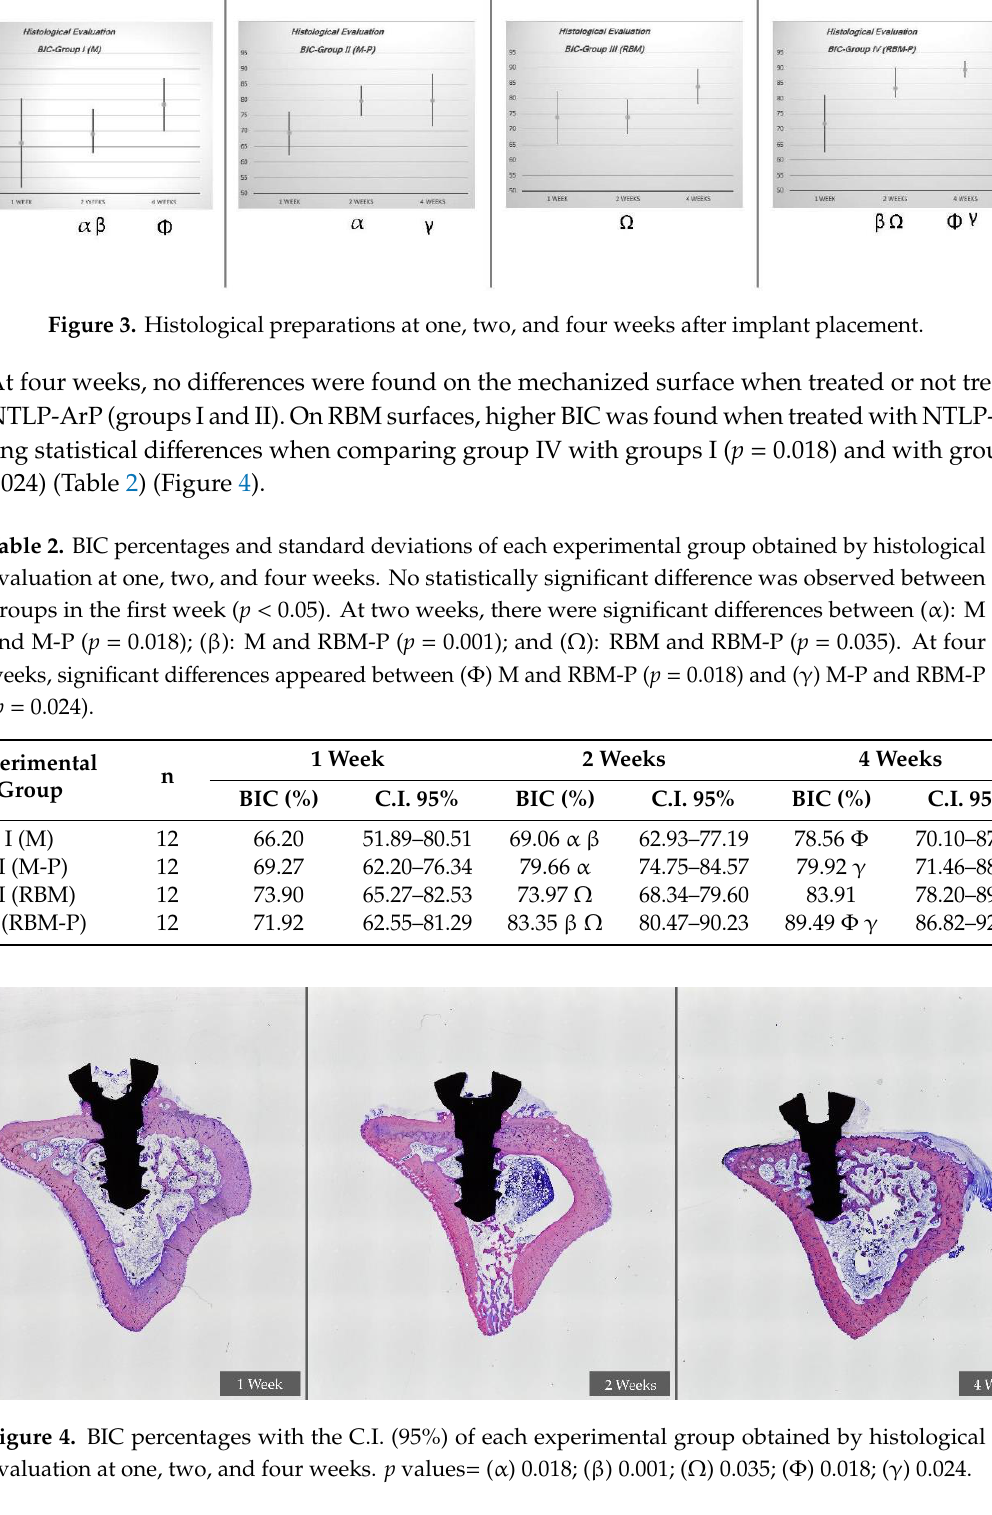
Table 2. BIC percentages and standard deviations of each experimental group obtained by histological evaluation at one, two, and four weeks. No statistically significant difference was observed between groups in the first week ( p < 0.05). At two weeks, there were significant differences between (α): M and M-P ( p = 0.018); (β): M and RBM-P ( p = 0.001); and (Ω): RBM and RBM-P ( p = 0.035). At four weeks, significant differences appeared between (Φ) M and RBM-P ( p = 0.018) and (γ) M-P and RBM-P ( p = 0.024).